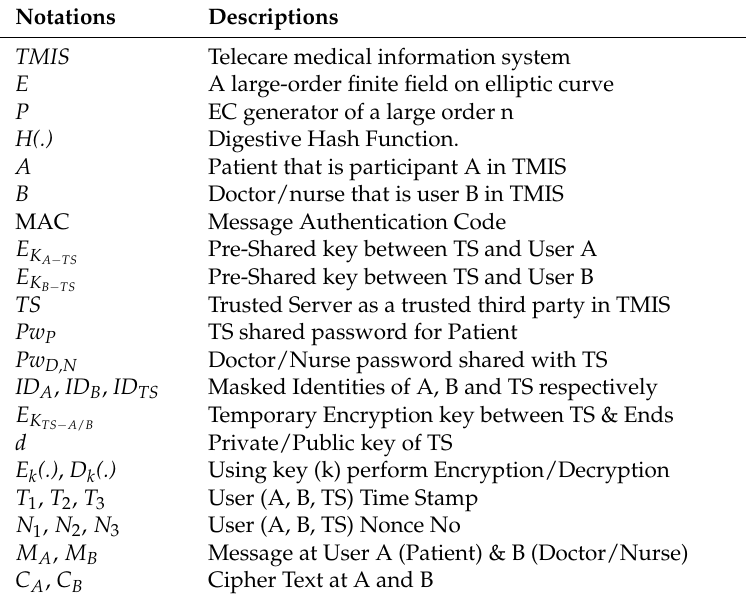
Table 1. Abbreviations and acronyms for Secure Authentication and Prescription Safety